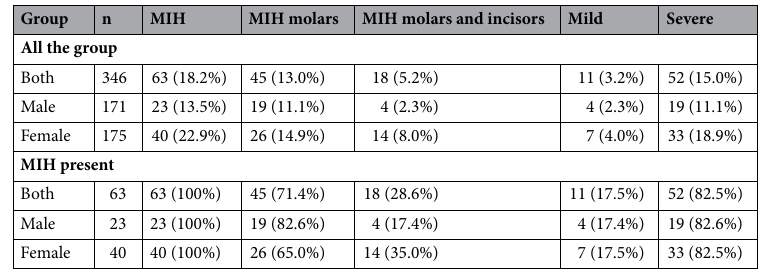
Table1. Gender-based analysis of MIH in the whole sample and in the affected groups.